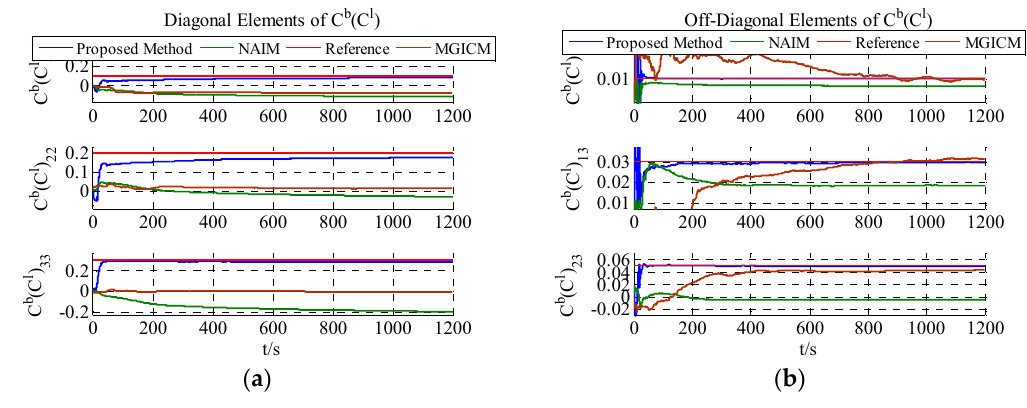
Figure 9. Estimation result of magnetometer scale factors.